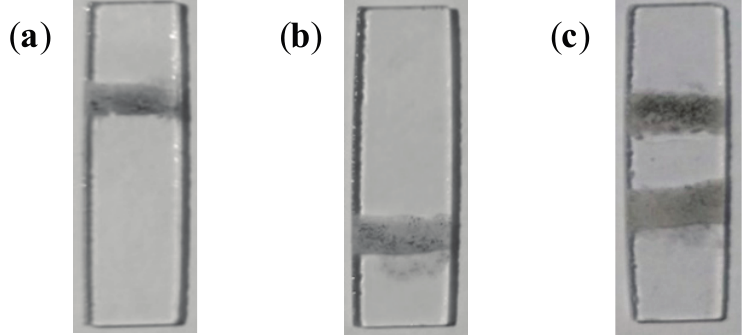
Figure 5. Glass slides showing ( a ) visual signal obtained at the first capture zone from the detection of Pf HRP-2 in PBS; ( b ) signal observed at the second capture zone from the detection of Pv MSP-1 in solution; and ( c ) signals obtained at the Pf HRP-2 and Pv MSP-1 capture zones from a mixed Pf HRP-2 and Pv MSP-1